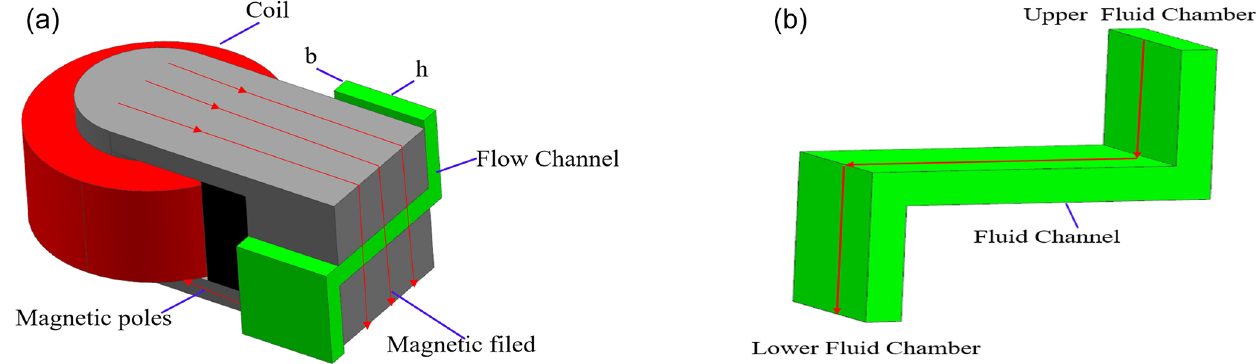
Figure 2. Controlled channel and coil arrangement (a) Coil and channel assembly diagram and (b) controlled channel.